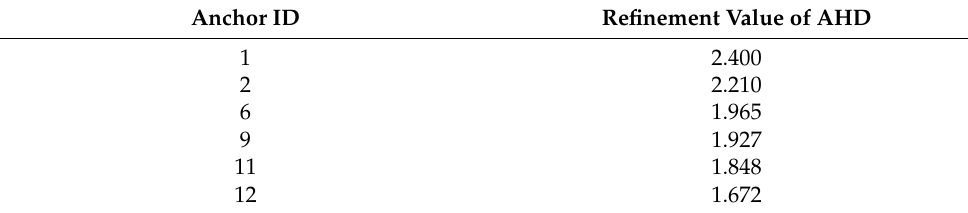
Table 4. Refinement step in AHD for specific threshold “6”.